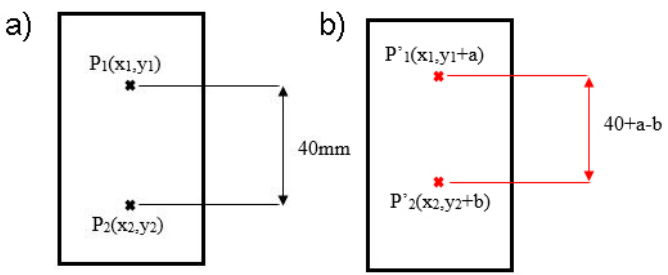
Figure5. ( a )Definitionofpointsforthecalculationofthestrainand( b